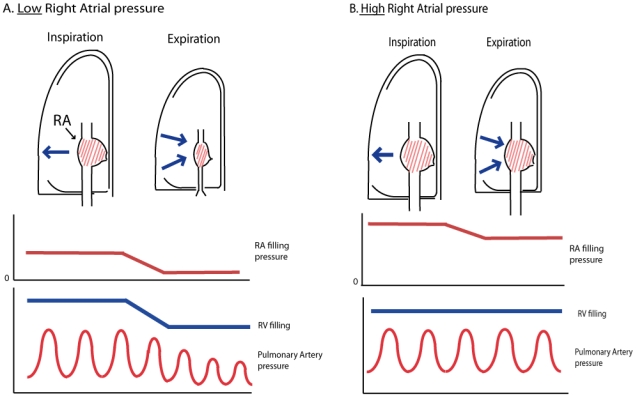
Schematic illustration of the effect of similar intrathoracic pressures (blue arrows) on right atrial (RA) filling, RV filling and the pulmonary artery pressure in a situation of either a low (A) or high (B) right atrial pressure.When RAP is low, the positive intrathoracic pressure during expiration leads to an impaired venous return and a variation in RV filling and stroke volume during the respiratory cycle. When RAP pressure is high, the right atrium acts as a reservoir which maintains RV filling and ensures a stable pulmonary artery pulse pressure and RV stroke volume during expiration.